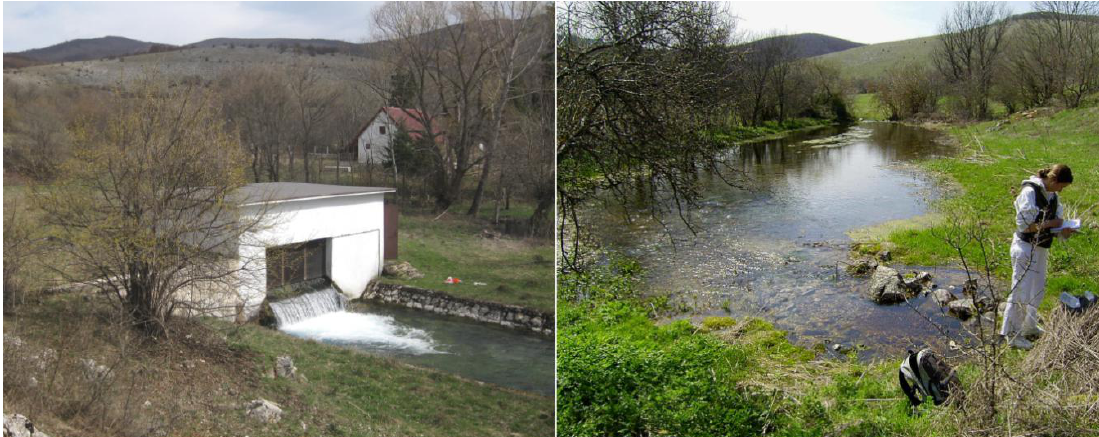
Figure 2. Intake building of the main spring (left) and periodic spring-lake (right).